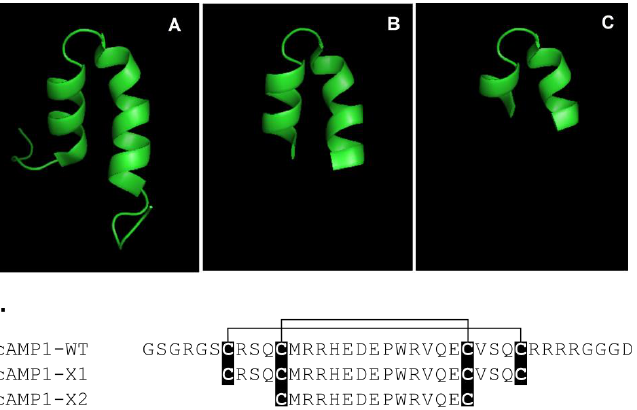
Figure 1. Structures of the wild-type EcAMP1 and its truncated synthetic analogs EcAMP1-X1 and EcAMP1-X2. Modeling of spatial structure of wild-type EcAMP1-WT ( A ); truncated form of EcAMP1-X1 restricted up to outer disulfides ( B ); truncated form of EcAMP1-X2 restricted up to inner disulfides ( C ); multiple alignment of EcAMP1-WT, EcAMP1-X1, and EcAMP1-X2 ( D ); Cys residues are shown in black boxes, and disulfide bridges are shown as black lines above.